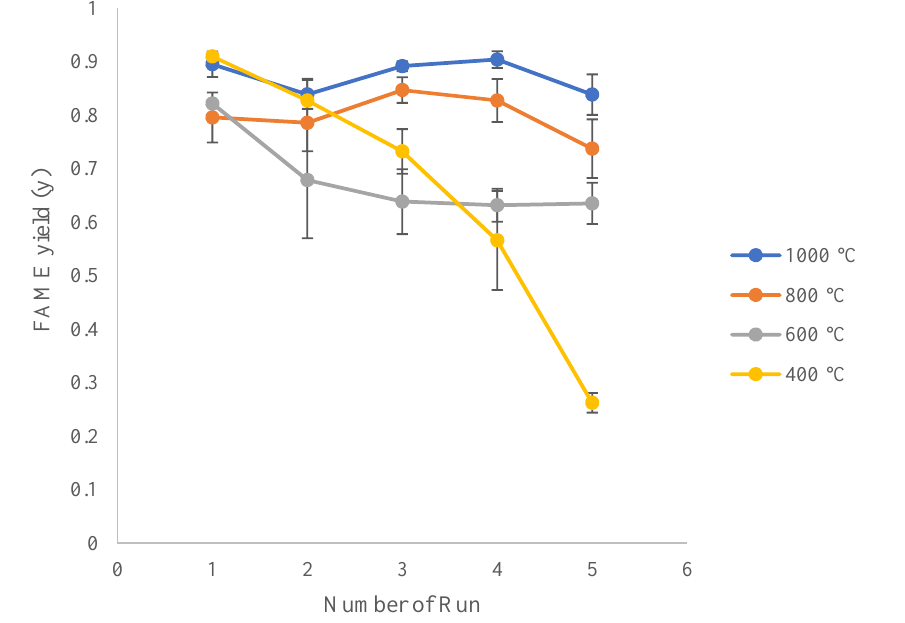
Figure 3. The FAME yield of repeated transesterifications reaction catalyzed by the same spent NaOH 6 /shell calcined at various temperatures. Transesterification conditions: temperature = 62 °C; stirring rate = 800 rpm; MR = 12; CL = 10%.